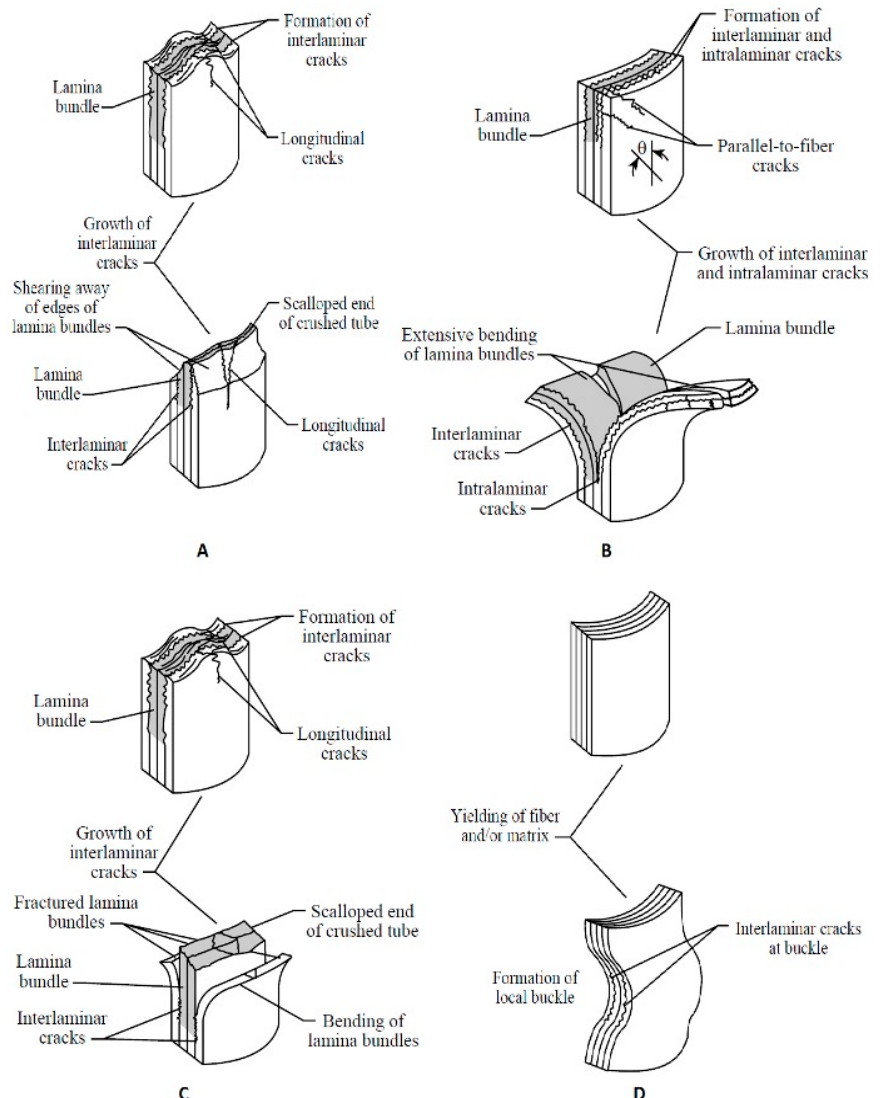
Figure 2. Typical failure modes observed in CFRP tubes undTheer axial crushing [6]. ( A – D ), represent typical key failure modes that are observed.